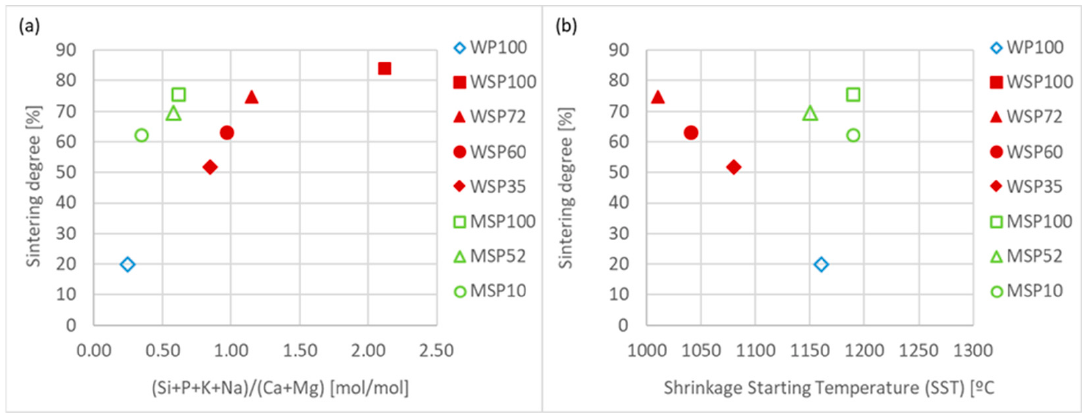
Figure 13. ( a ) Mean sintering degree of the bottom ash versus ratio (Si + P + K + Na)/(Ca + Mg); ( b ) Mean sintering degree of the bottom ash versus fuel shrinkage starting temperature (SST).